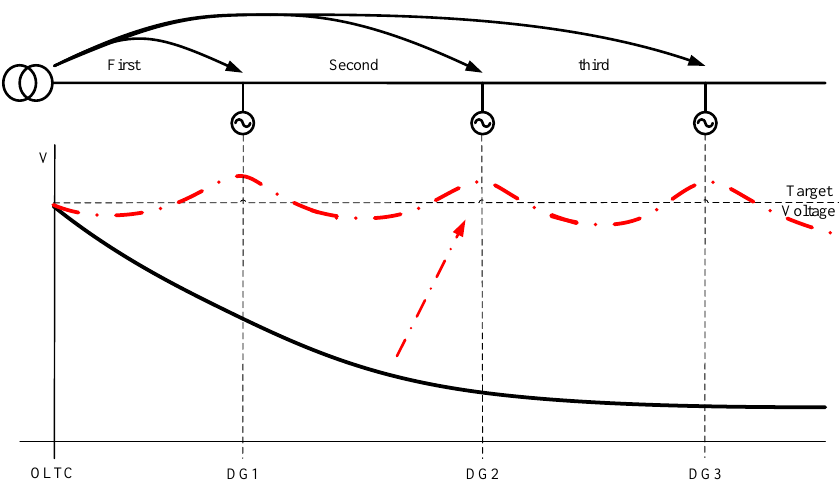
Figure 8. Voltage flattening by reactive power of DGs.